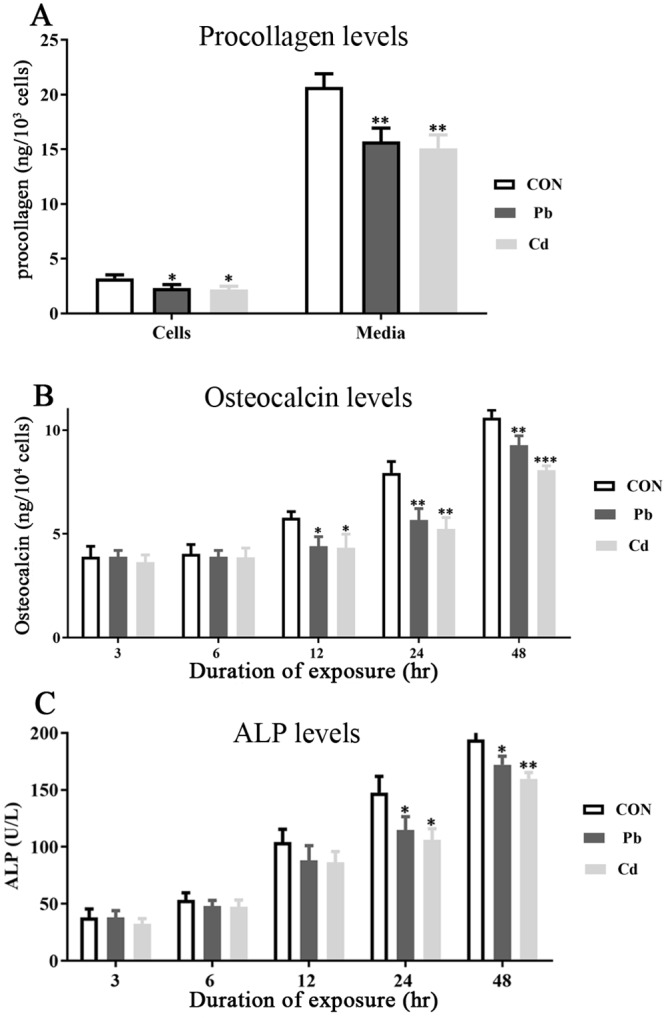
The effect of lead or cadmium (Cd) on human osteoblast secretions.Human osteoblasts were treated with lead (Pb) (55 μM) or cadmium (Cd) (30 μM), and the level of procollagen type I peptide within the cells and released into the culture media quantified (A). At 3, 6, 12, 24, and 48 hours post-treatment with lead or cadmium, the levels of osteocalcin (B) and ALP (C) secreted into the culture media were quantified. Significant differences from controls are marked with asterisks. Data are representative of 5 independent experiments. For * = p-value < 0.05, ** = p-value < 0.01, *** = p-value < 0.0001.